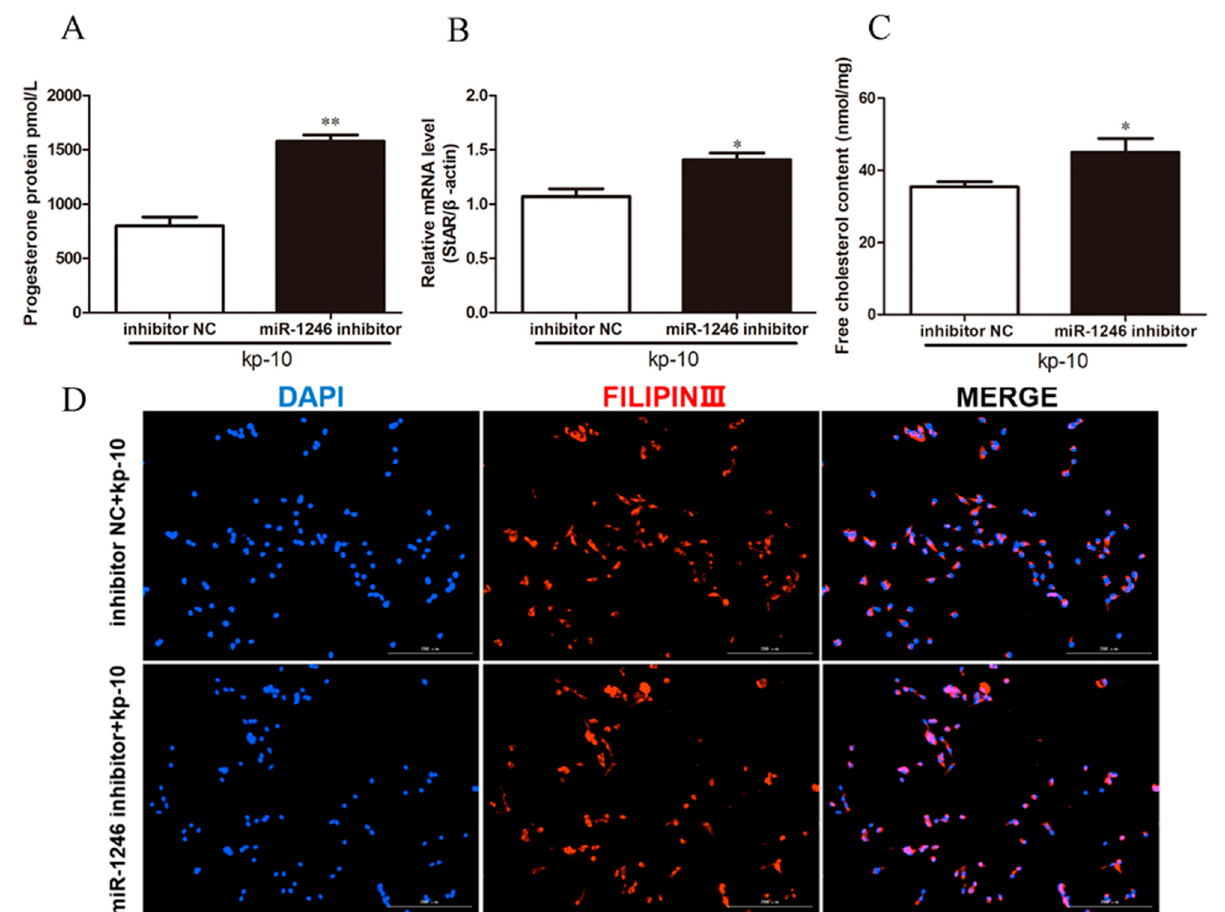
Figure 5. miR-1246 inhibitor enhanced the effect of kp-10 on P4 synthesis of BGCs. ( A ) The level of P4 in BGCs. ( B ) Relative StAR mRNA expression in BGCs. ( C ) Representative filipin staining of BGCs. ( D ) Relative free cholesterol content in BGCs. Inhibitor NC, negative control of miR-1246 inhibitor; miR-1246 inhibitor, underexpression of miR-1246. All data were presented as the mean ± SD ( n = 3), * p < 0.05, ** p < 0.01.